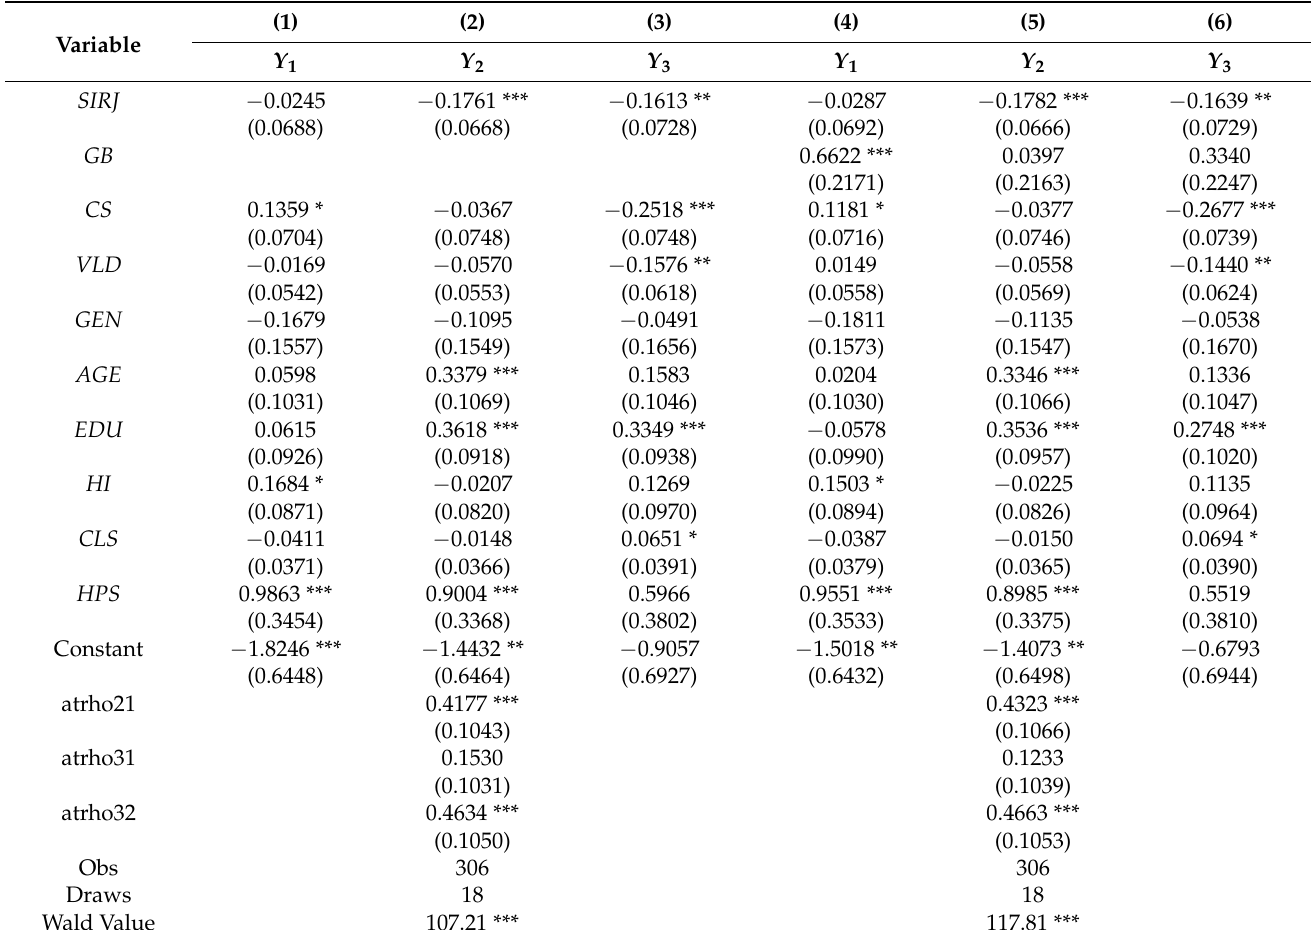
Table 3. MVP model standard regression